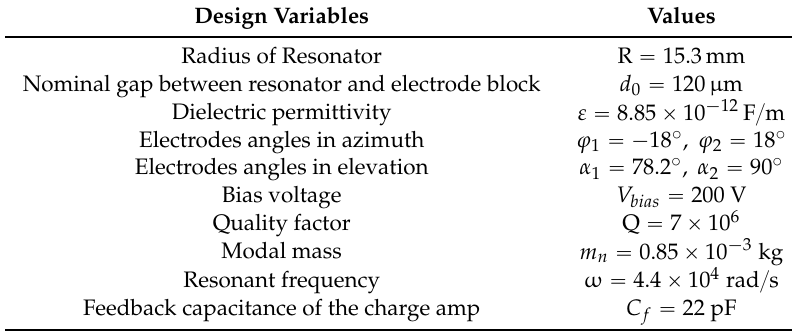
Table 2. The design variables for calculating the electromechanical gains.